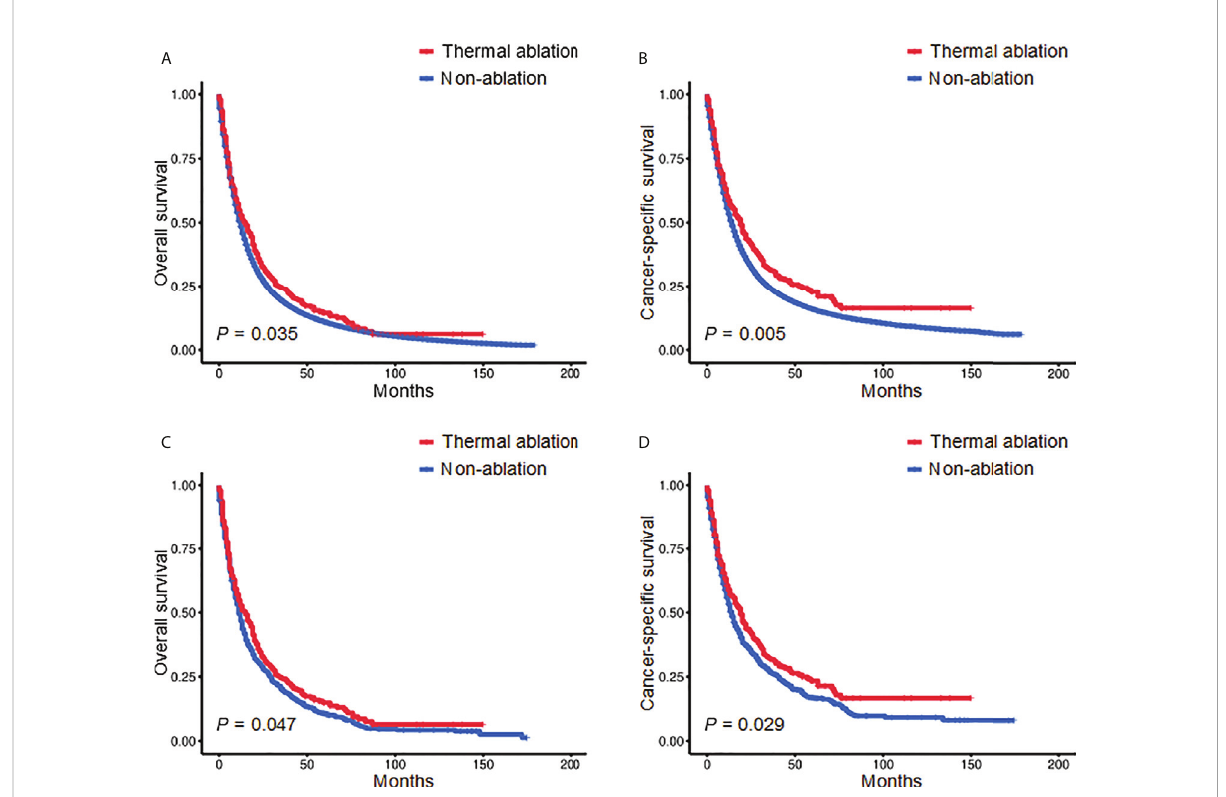
FIGURE 1 Kaplan-Meier survival curves of stage II-III NSCLC patients before (A, B) and after (C, D) PSM. NSCLC, non-small cell lung cancer; PSM, propensity score